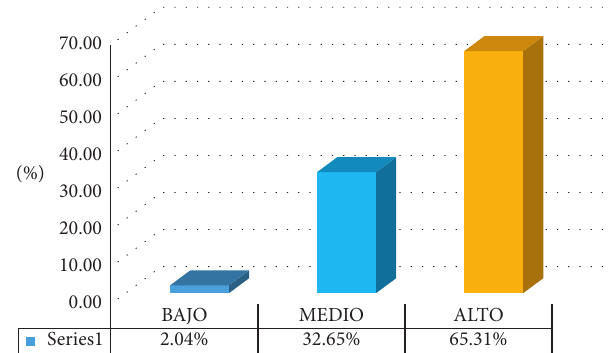
Figure 10: Category IV: decision-making: